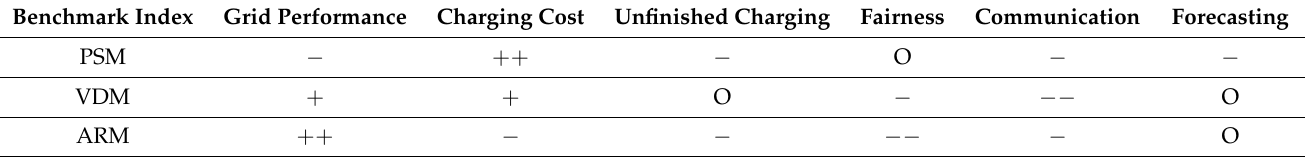
Table 4. Performance